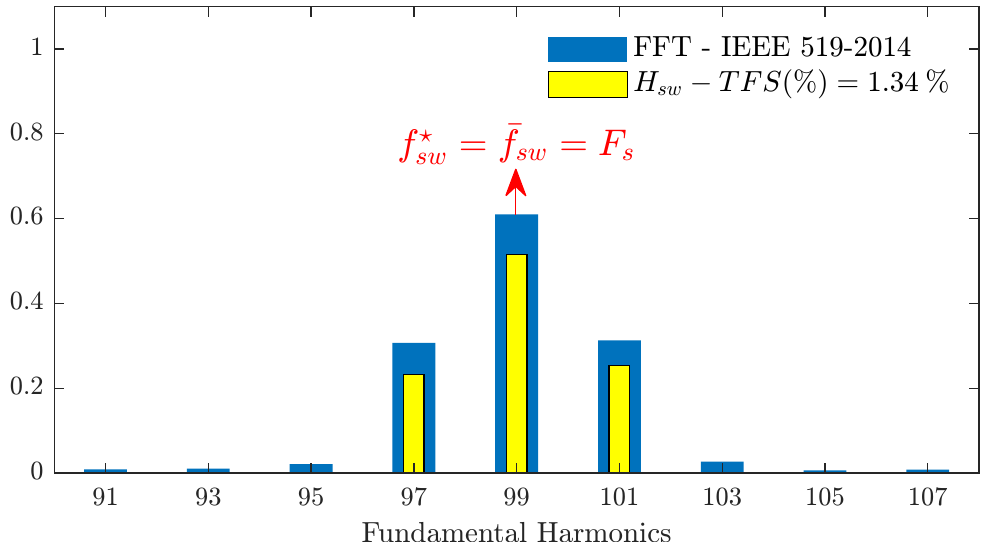
Figure 3. Ideal PWM-based converter: FFT of the switching pulses and the instantaneous switching frequency components ( H sw ) estimated by Algorithm